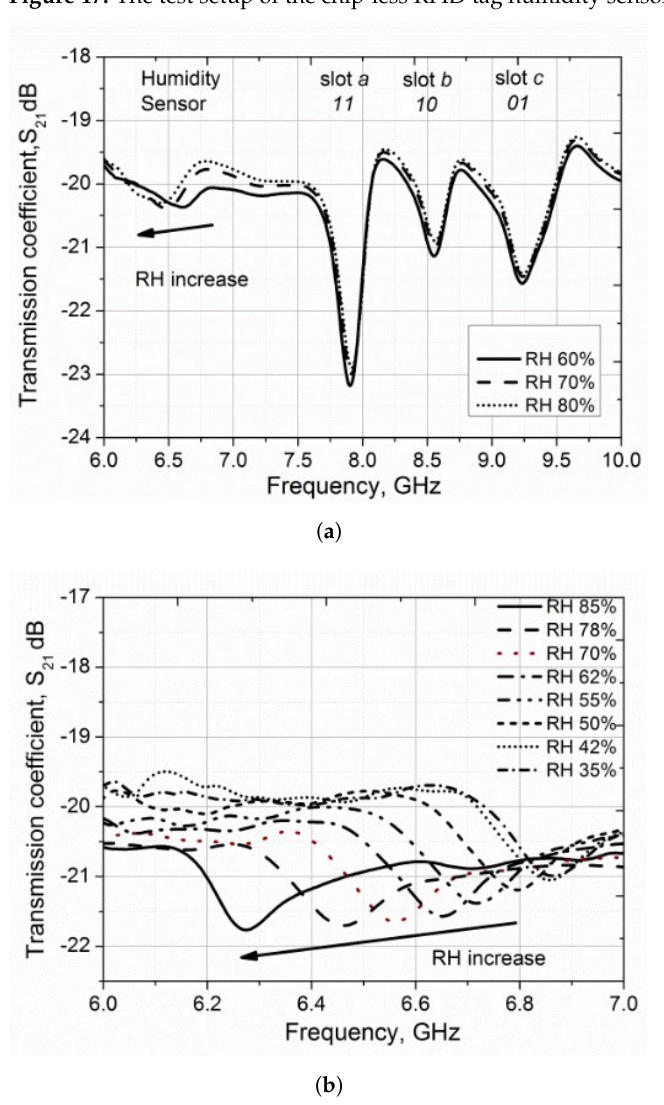
Figure 18. ( a ) Measured transmission coefficient (calibrated) (S21) versus frequency for the chip–less RFID humidity sensor with PVA coating. ( b ) Detailed experimental results with ELC resonator as a humidity sensor